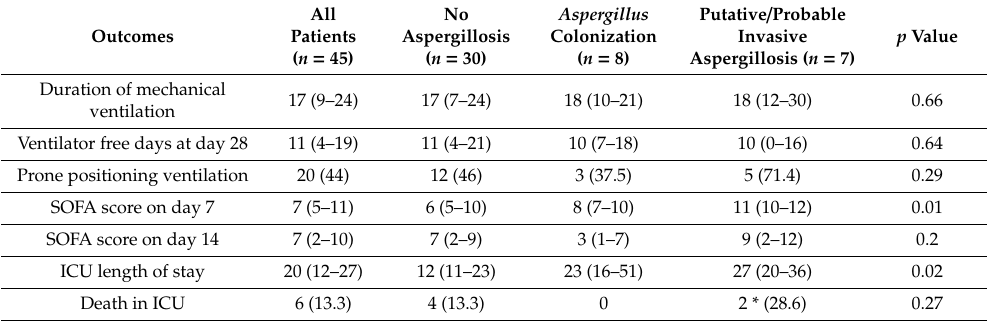
Figure 2. Computed tomography of the chest of patients with COVID-19 with secondary invasive aspergillosis. Unenhanced chest CT in a 59-year-old man with COVID-19 and biological markers of invasive aspergillosis performed at baseline ( A ) and at 12-day follow-up ( B ) showing subpleural ground-glass and reticular opacities presumed to correspond to COVID-19 lesions (arrowheads) as well as a right apical consolidation area presumed to correspond to invasive aspergillosis (arrow). Enhanced chest CT in a 69-year-old man with COVID-19 and biological markers of invasive aspergillosis showing at baseline ( C ) ground-glass opacities (arrowheads), and at 11-day follow-up ( D ) a left postero-basal consolidation presumed to correspond to invasive aspergillosis (arrow). (346-mm field of view, 512 × 512 image matrix, lung window (W1600 / L-500 HU)). Table 7. Outcomes of patients with COVID-19-associated ARDS according to Aspergillus